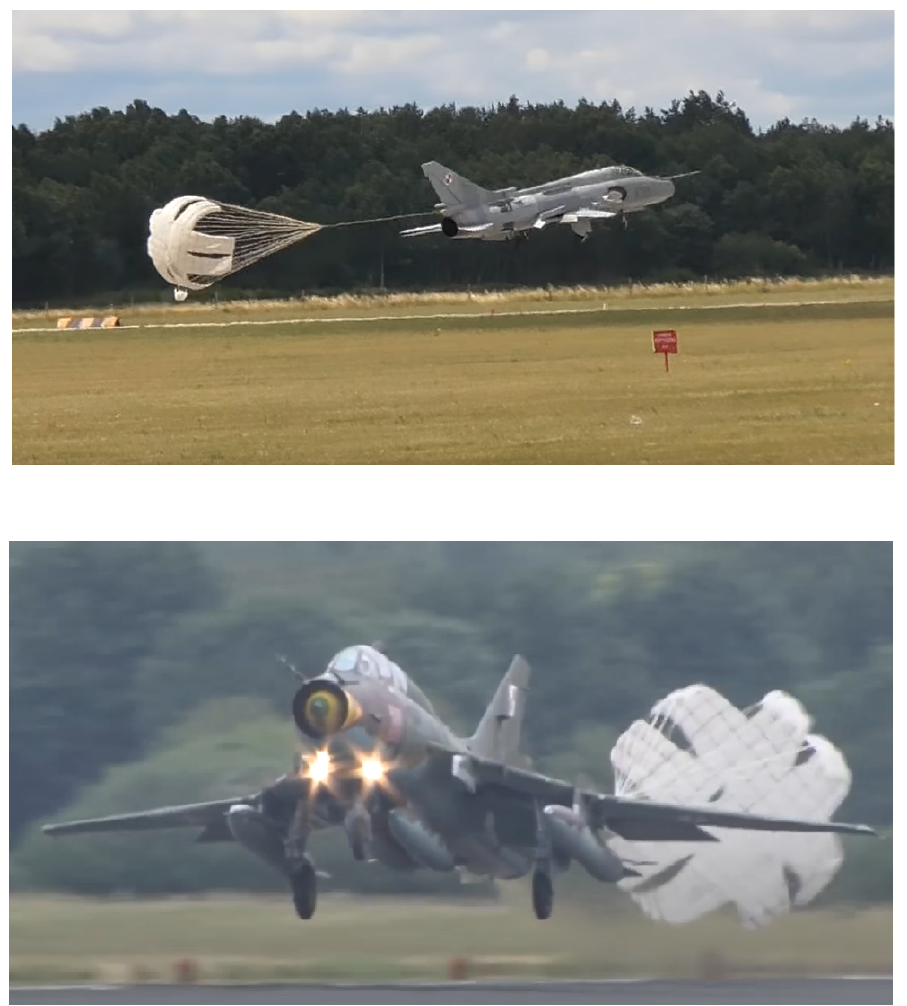
Figure 16. Examples of landings with prematurely opened drogue parachute [29–31].